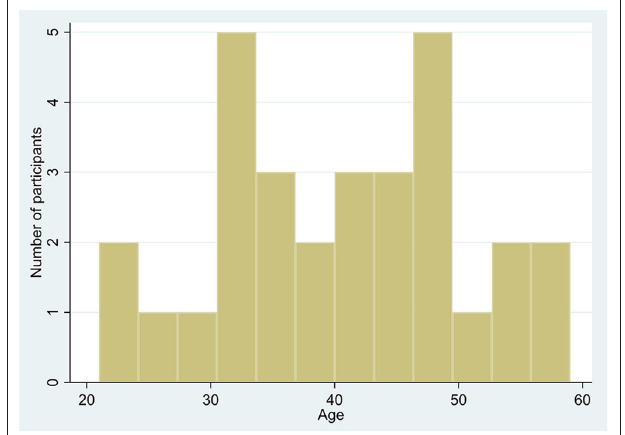
FIGURE 1 | Distribution of age.